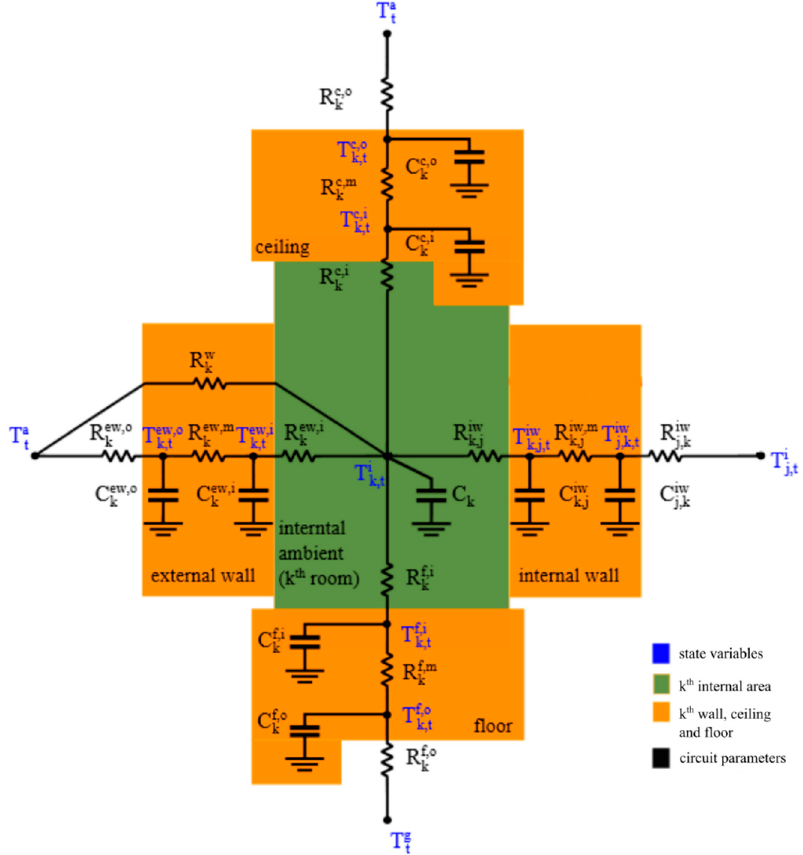
Figure 2. The equivalent circuit model for the generic k th room.